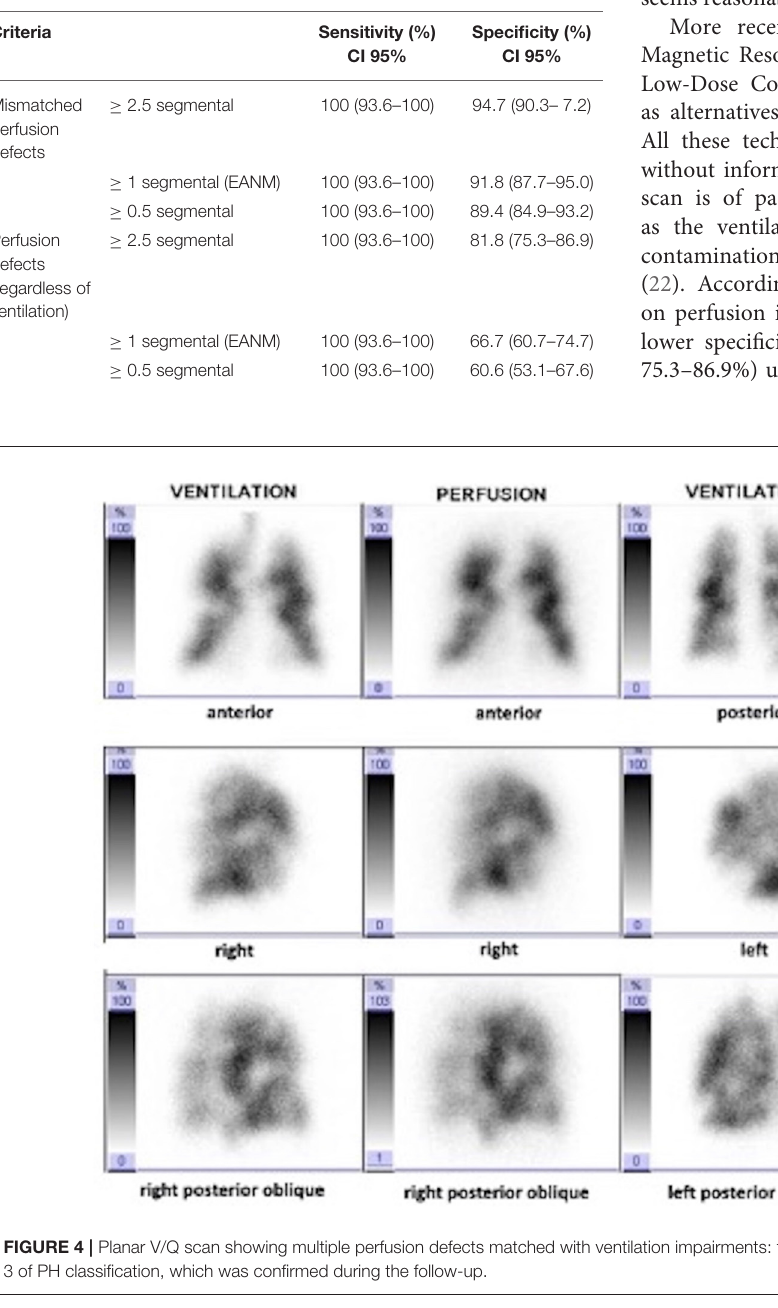
Frontiers in Medicine |